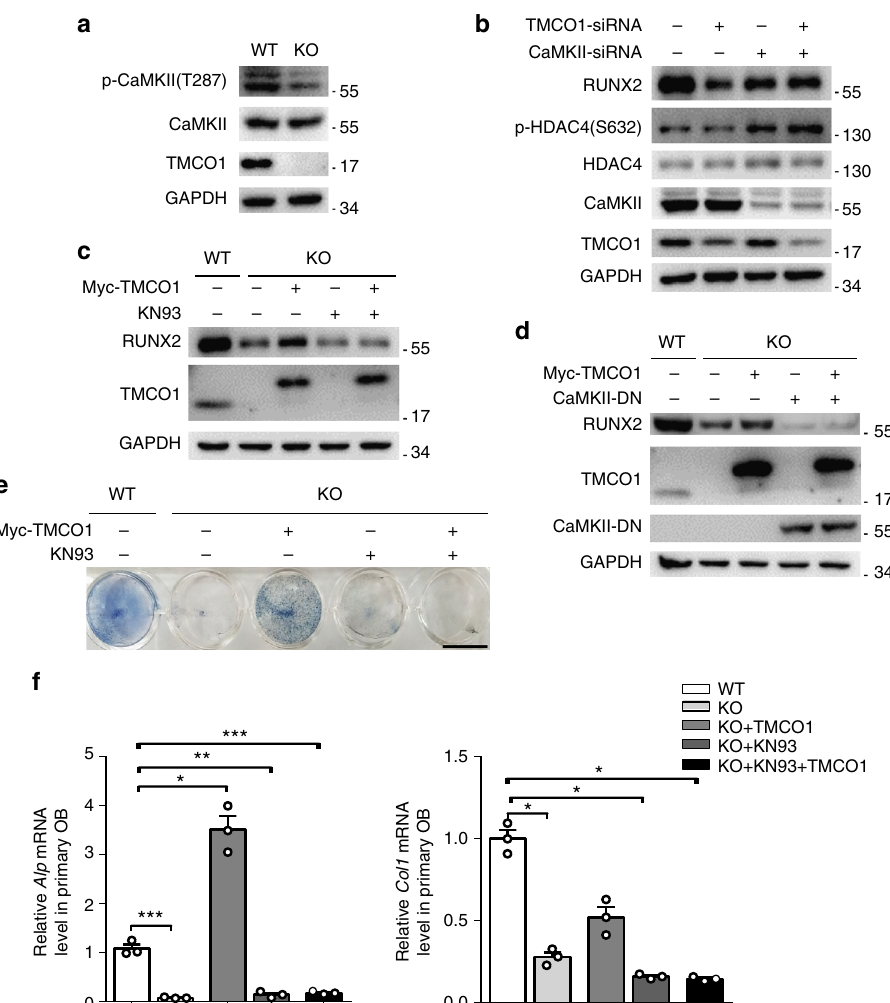
Fig. 5 Altered CaMKII signaling in TMCO1-de fi cient osteoblasts. a Western blot analysis of CaMKII protein expression and phosphorylation in WT and TMCO1 − / − osteoblasts. Representative results of three independent experiments are shown. b CaMKII de fi ciency restricts the effect of TMCO1 knockdown on RUNX2 expression. MC3T3-E1 cells were transfected with CaMKII-siRNA and/or TMCO1-siRNA. The protein levels of RUNX2 and TMCO1 were determined by western blotting. Representative results of three independent experiments are shown. c Effect of KN93 on RUNX2 expression caused by TMCO1 de fi ciency. WT and Tmco1 − / − primary osteoblasts were infected with an adenovirus expressing TMCO1 in the presence or absence of treatment with the CaMKII inhibitor KN93. Representative results of three independent experiments are shown. d Effect of DN-CaMKII (dominant-negative CaMKII) on RUNX2 expression caused by TMCO1 de fi ciency. WT and Tmco1 − / − primary osteoblasts were infected with an adenovirus expressing TMCO1 in the presence or absence of treatment with DN-CaMKII. Representative results of three independent experiments are shown. e Effect of CaMKII de fi ciency on ALP staining caused by TMCO1 de fi ciency. WT and Tmco1 − / − primary osteoblasts were infected with an adenovirus expressing TMCO1 in the presence or absence of treatment with the CaMKII inhibitor KN93. Scale bars, 6 mm. f Effect of CaMKII de fi ciency on osteoblast-speci fi c genes caused by TMCO1 de fi ciency. WT and Tmco1 − / − primary osteoblasts were infected with an adenovirus expressing TMCO1 in the presence or absence of treatment with the CaMKII inhibitor KN93, n = 3. Each group was compared with the WT. Data are presented as the mean ± s.e.m. one-way ANOVA with multiple